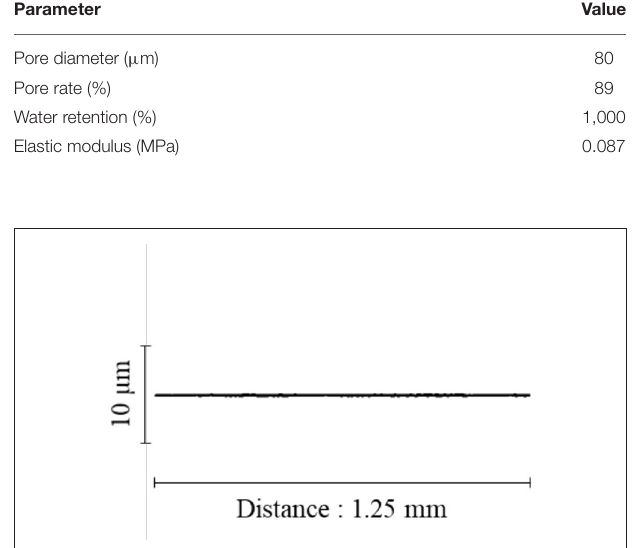
FIGURE 4 | Surface profile of the rotating shaft before